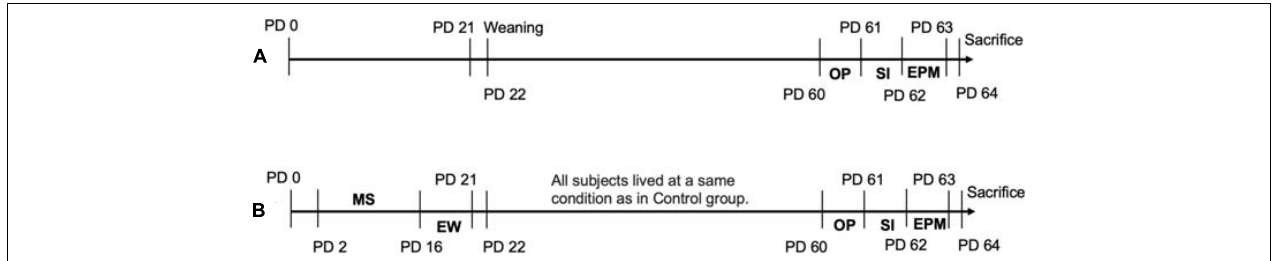
FIGURE 1 | Experimental schedule and MSEW paradigm. (A) Shows the experimental schedule set up for rats in Control group. (B) Shows the MSEW paradigm and experimental schedule for rats in MSEW group. EPM, elevated plus maze test; EW, early weaning; MS, maternal separation; OP, open field test; PD, postnatal day; SI, social interaction